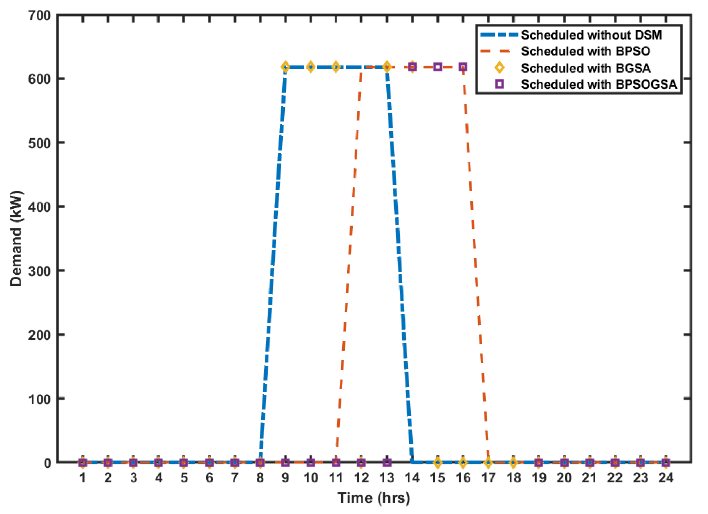
Figure 11. Shifting of 3-phase air conditioner loads before and after deployment of DSM.